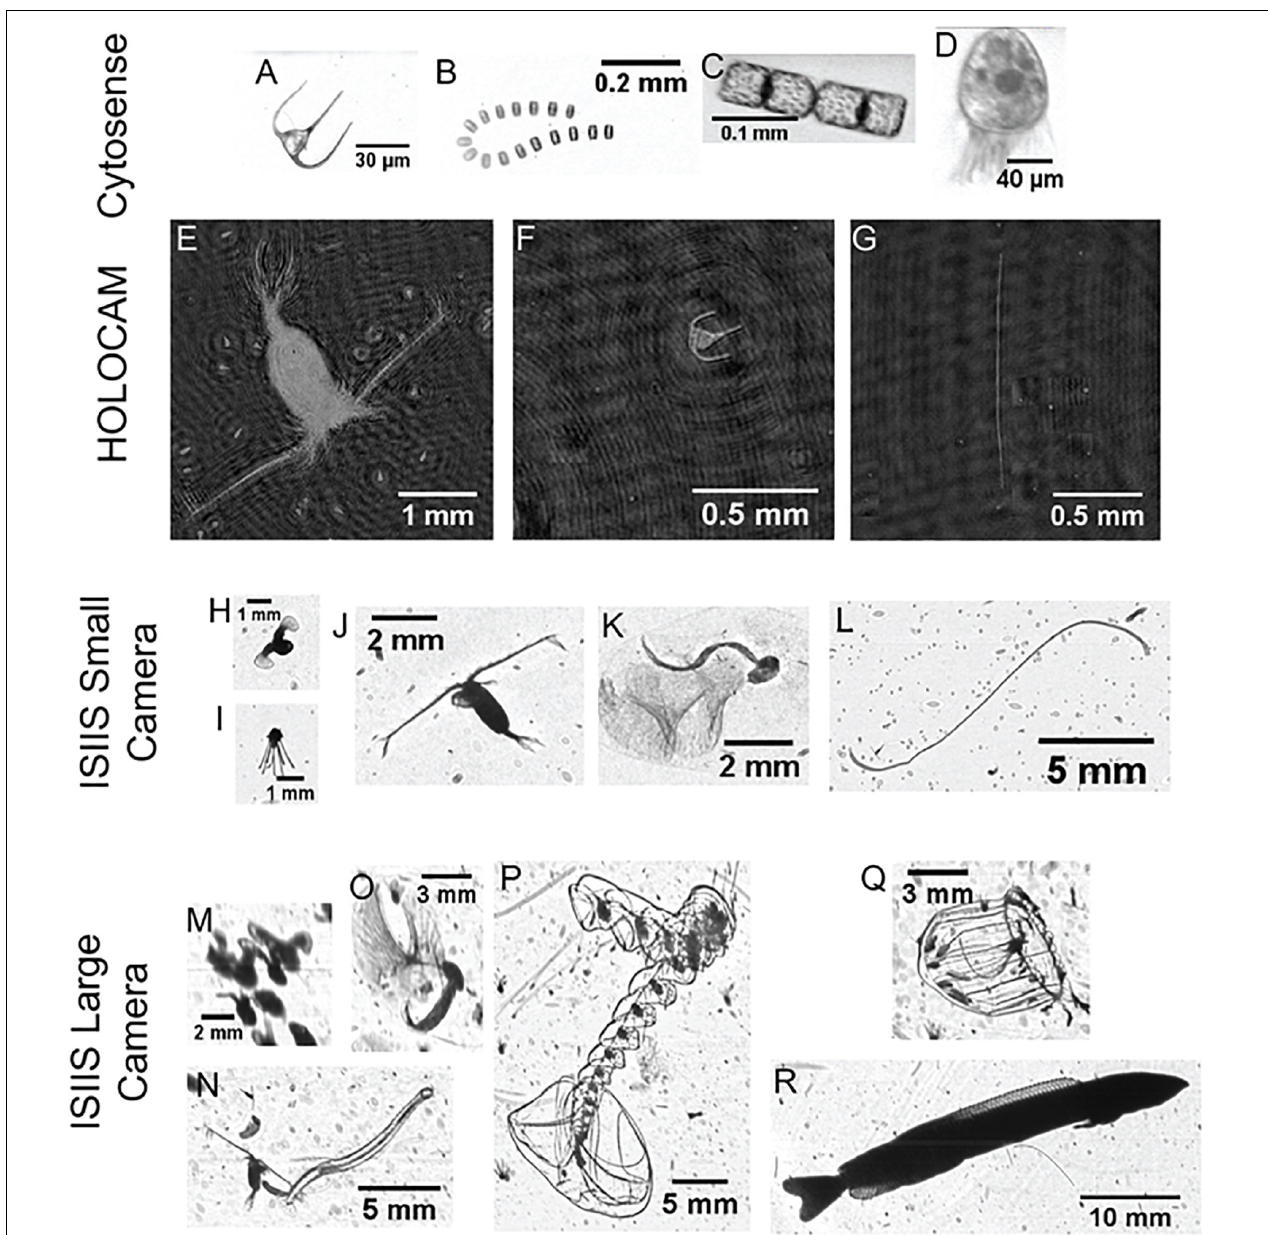
FIGURE 6 | Example organisms detected by different imaging systems. For the Cytosense, (A) Ceratium spp. dinoflagellate, (B) Thalassiosira spp. diatom and (C) Cerataulina spp. diatom and (D) a ciliate (likely Strombidium spp.). For the HOLOCAM, (E) calanoid copepod (with numerous ciliates in the background), (F) Ceratium spp., and (G) diatom chain (genus and species not resolvable). For the ISIIS small camera, (H) veliger (early stage pteropod), (I) echinoderm larva, (J) calanoid copepod, (K) appendicularian, (L) diatom chain with numerous unresolved particles in the background. For the ISIIS large camera, (M) multiple veligers that appear to be touching, generating a large ‘particle’ (imaged through the 50-cm depth of field), (N) chaetognath and copepod, (O) appendicularian, (P) siphonophore ( Sphaeronectes spp.), (Q) hydromedusa ( Aglantha spp.), (R) juvenile sand lance ( Ammodytes